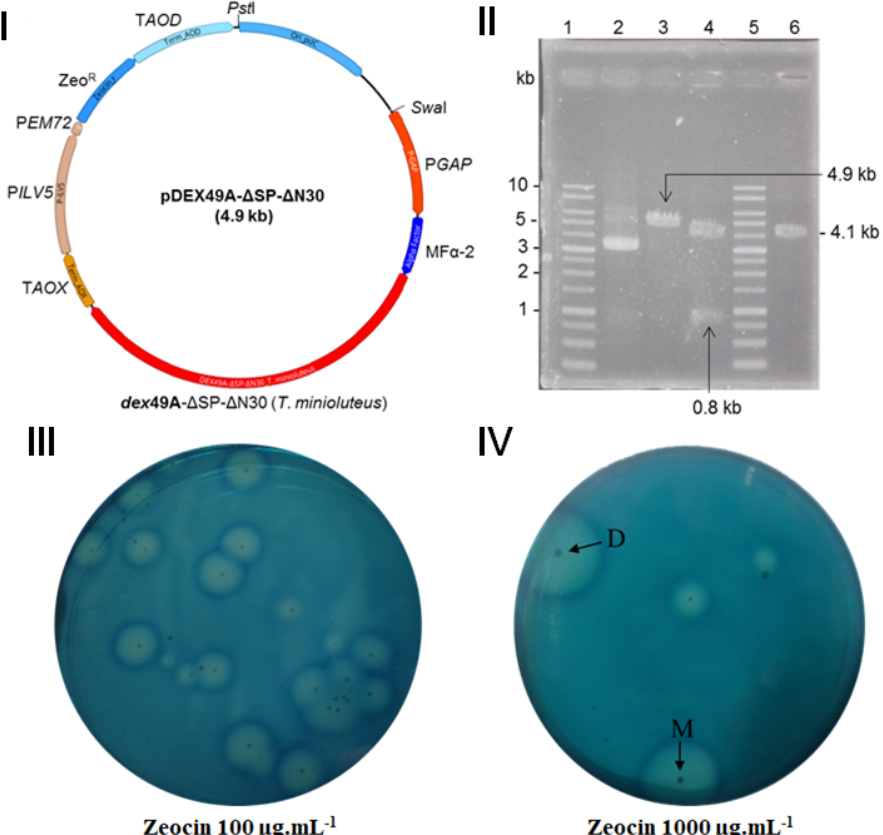
Figure 1. General cloning and screening strategy to isolate dextranolytic K. phaffii clones.